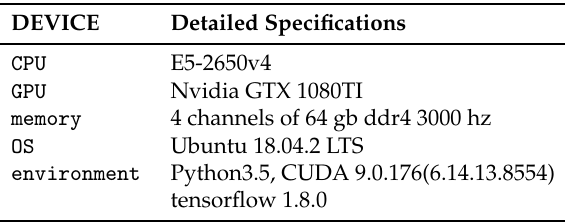
Table 2. Experiment